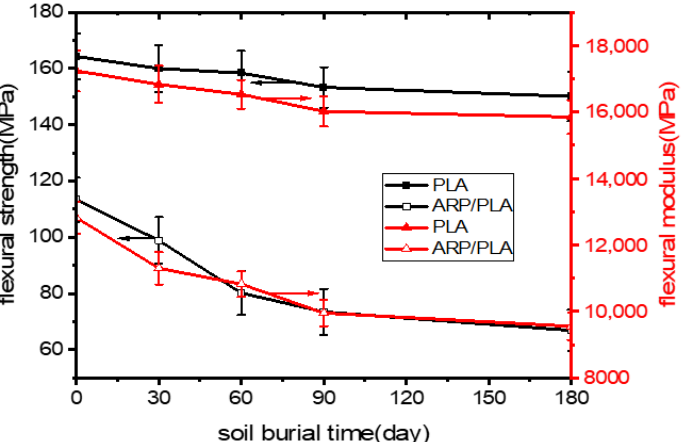
Figure 6. Bending properties of different specimens during degradation: (1) bending strength; (2) bending modulus.